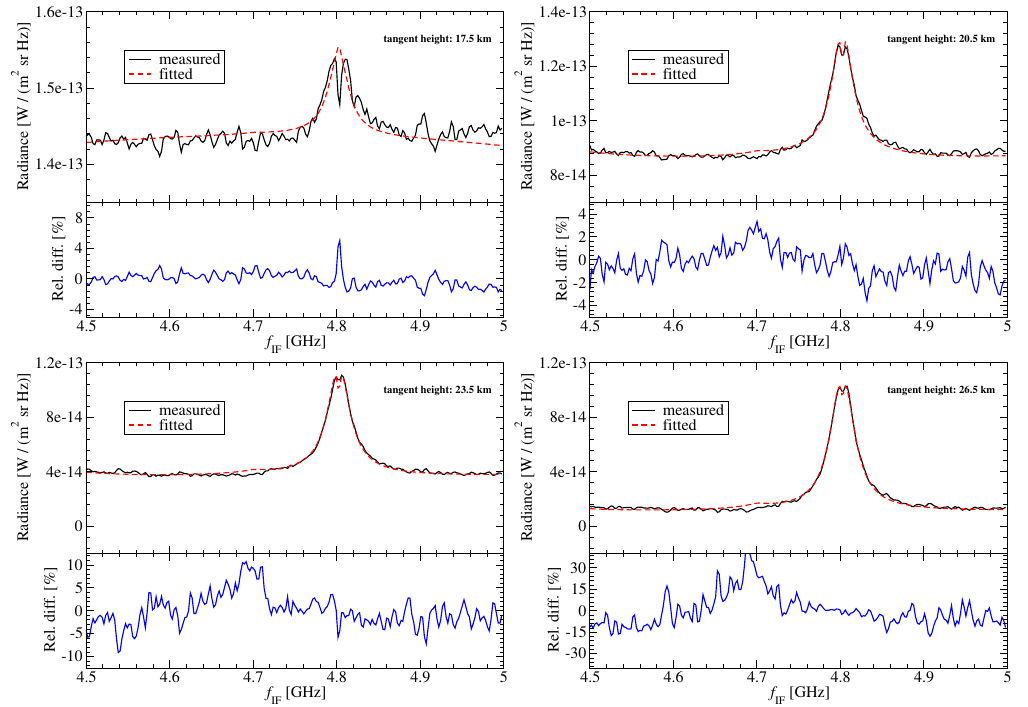
Figure 12. Comparison of measured and modeled TELIS CO spectra in segment 2. The dedicated measurement identifier is 20864 and the corresponding f LO is 1836.5428GHz. Four spectra are plotted for tangent heights at 17.5km, 20.5km, 22.5km, and 26.5km,